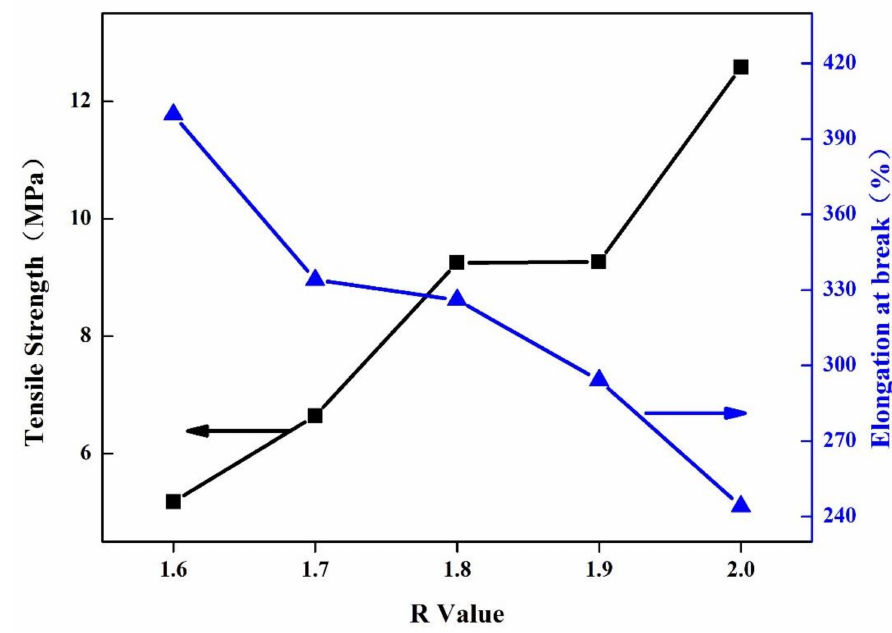
Figure 12. Mechanical properties of SPU films with different R